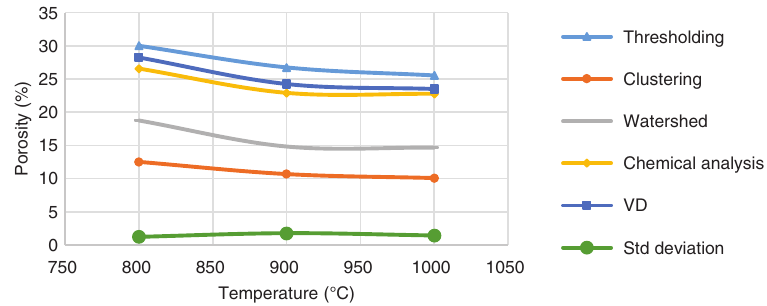
Figure 3: Porosity Estimation-Based VD versus Physical Process for the Sample S 10